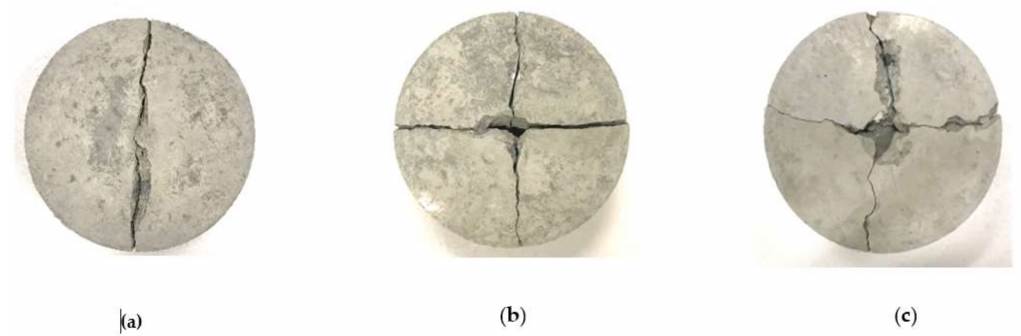
Figure 12. The failure photos of the specimen under repeated impact at 50 J: ( a ) I-B; ( b ) I-K5/C5; and ( c ) I-K5/C5.